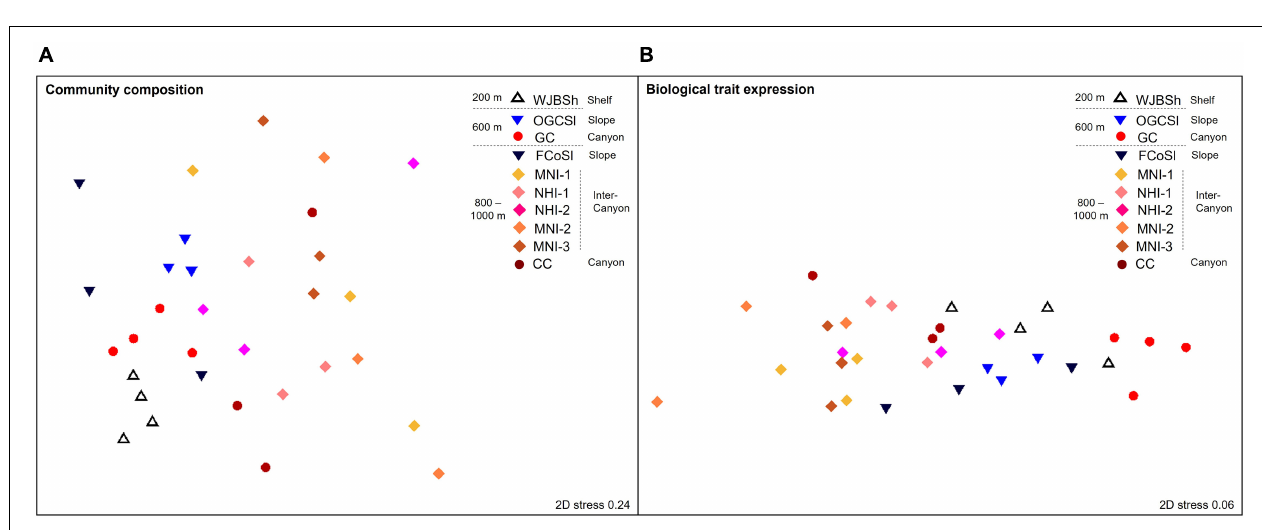
FIGURE 4 | Macrofaunal density, taxonomic diversity and vertical distribution in the 10 stations (average ± standard deviation). (A) Total macrofaunal density, (B) Total number of taxa, (C) Pielou’s evenness (J’), (D) Percentage of organisms in the 0–5 cm layer. Vertical dashed lines indicate the three depth classes used in the analysis (200, 600, and 800–1000 m). Symbols (*, **) highlight significant differences among habitats within each depth class (ANOVA, p < 0.05 or p < 0.01, respectively).